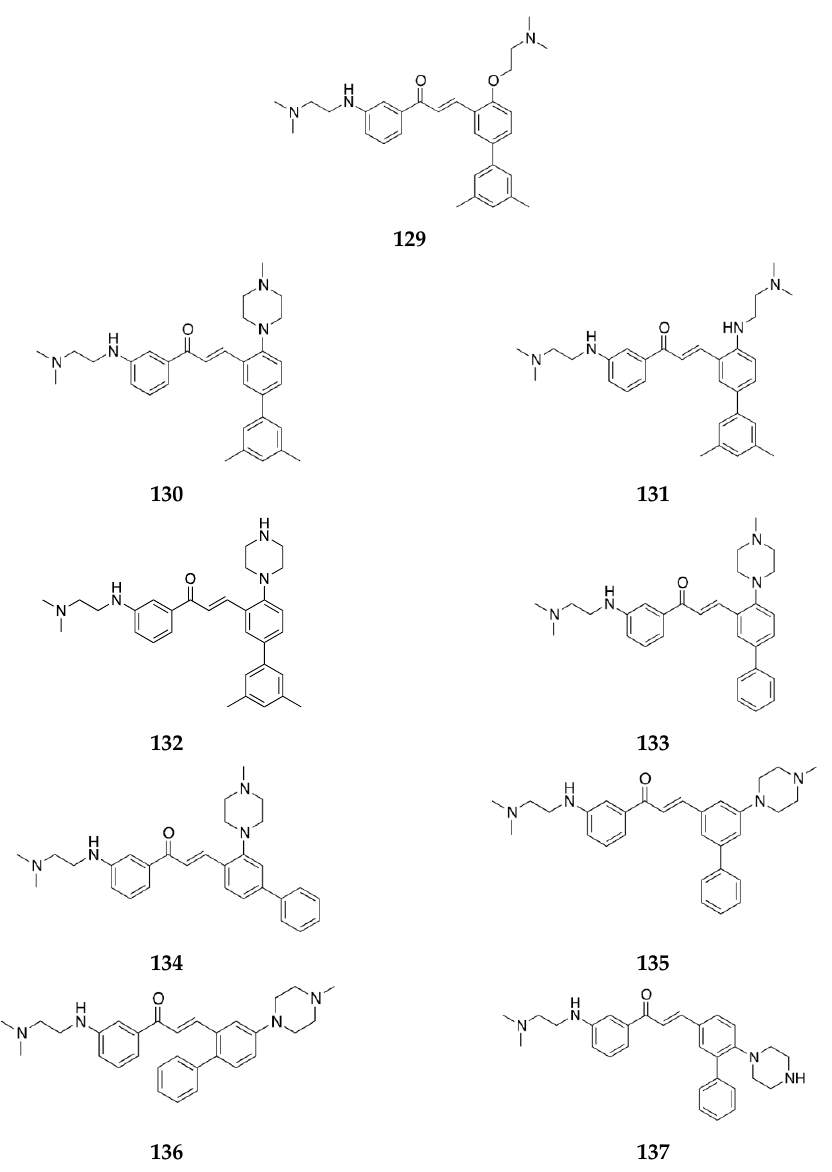
Figure 51. Chemical structures of 3-aminochalcones derivative chalcones with an acridinyl group. Compounds 129 – 137 were tested against gram-positive and -negative bacteria, namely, S. aureus ATCC33591 (resistant to methicillin), E. faecium 17501 (vancomycin-resistant clinical isolate), E. faecium ATCC29212, and E. coli ATCC25922. Table 23 shows the MIC. Table 23. MIC values for compounds 129 – 137 against the S. aureus ATCC33591 (resistant to